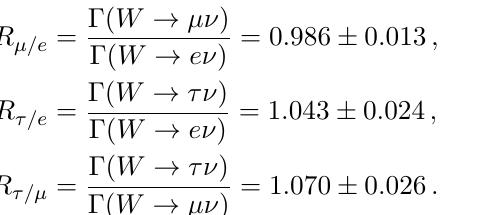
& 0 : 4, which (cid:28)(cid:23)